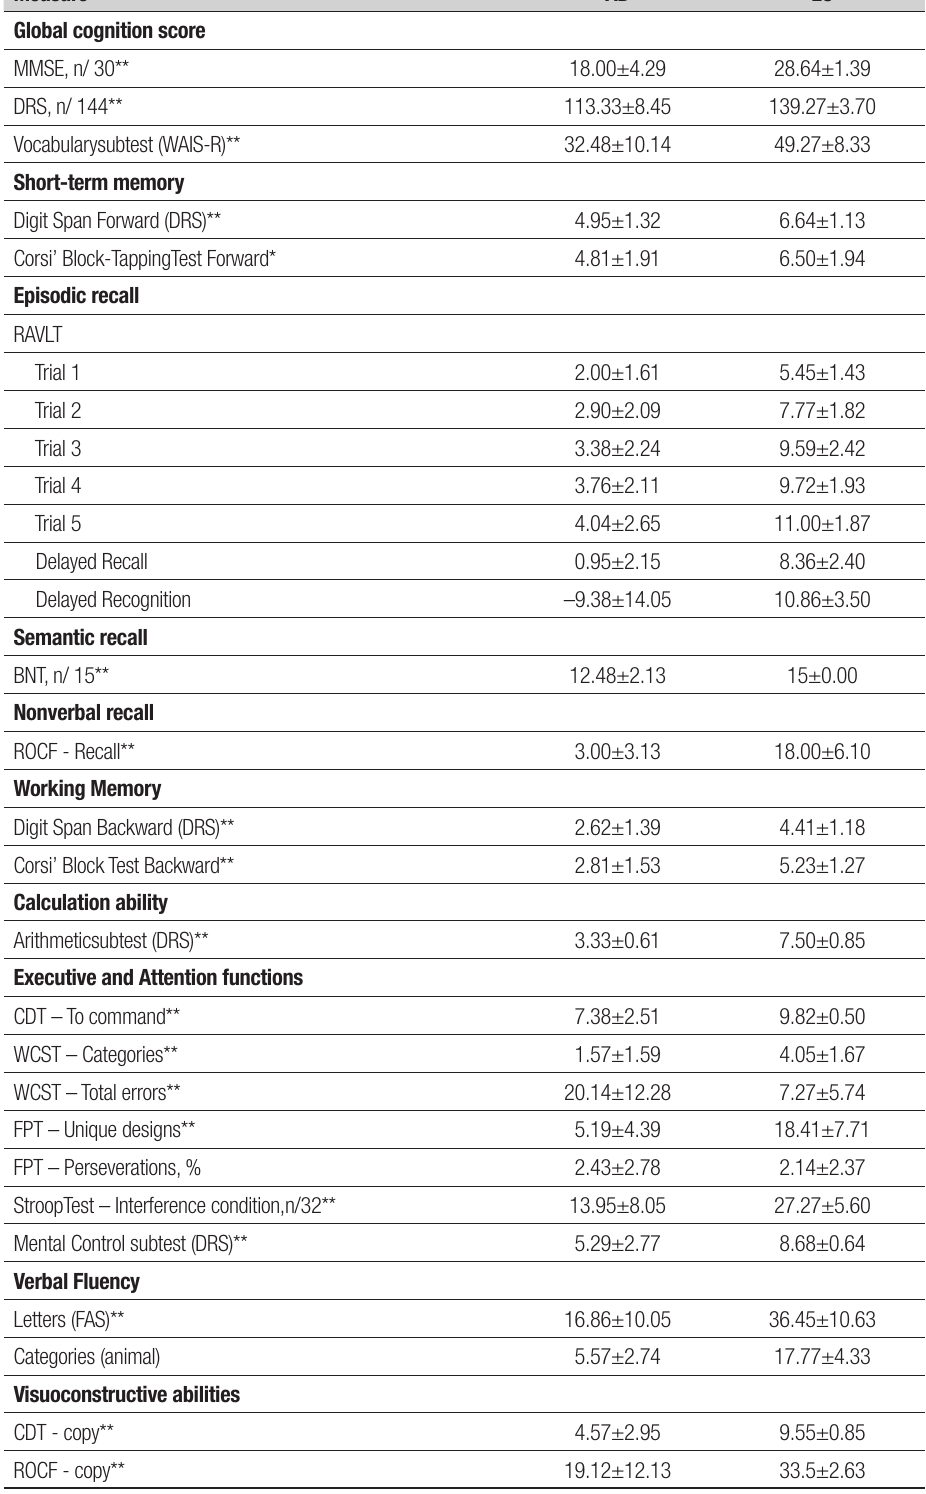
Table 2. Test performance of AD patients and elderly